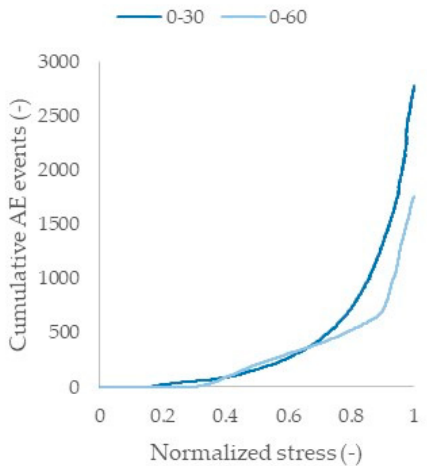
Figure 16. Total AE events recorded for the two laminates during the static tests.